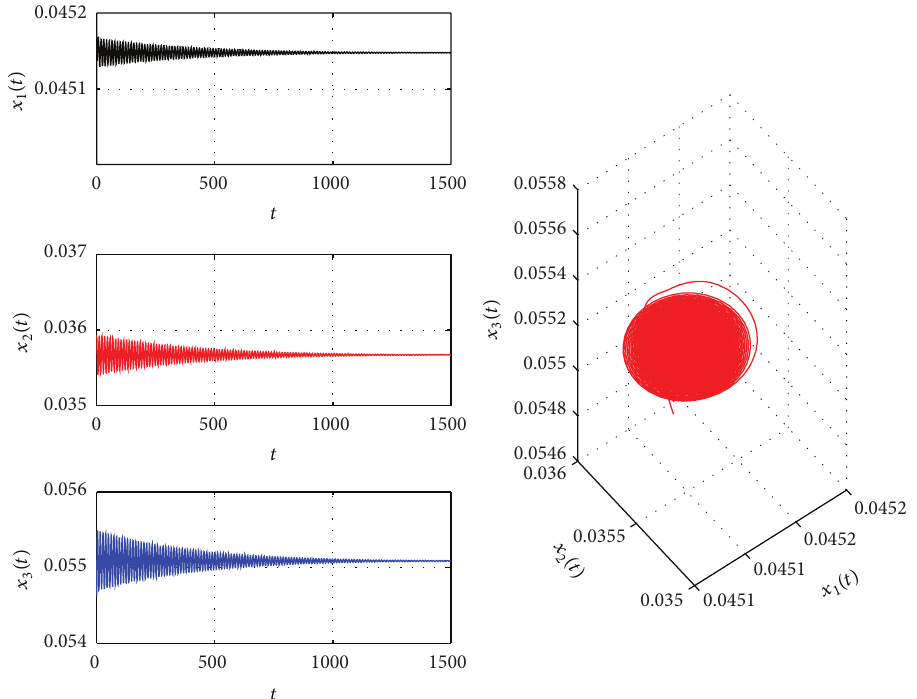
Figure 3: The trajectories and the phase graph with 𝜏 1 = 0.9, 𝜏 2 = 2.9 ; 𝐸 ∗ is locally asymptotically stable.